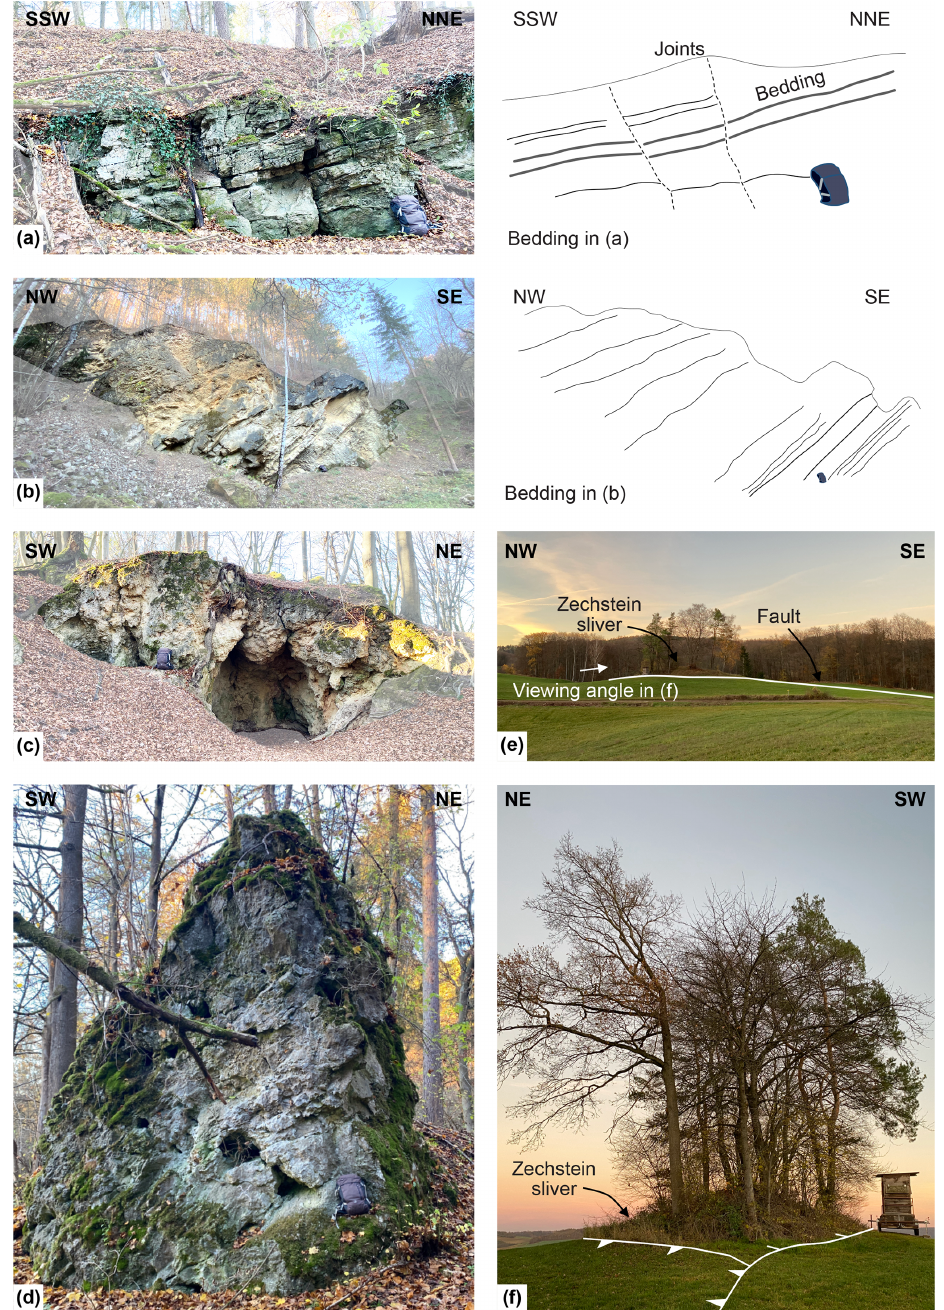
Figure 5. Photo panel of selected outcrops of Zechstein slivers along the Sontra Graben. The backpack is shown for scale. Approximate locations for each photo can be seen in Fig.